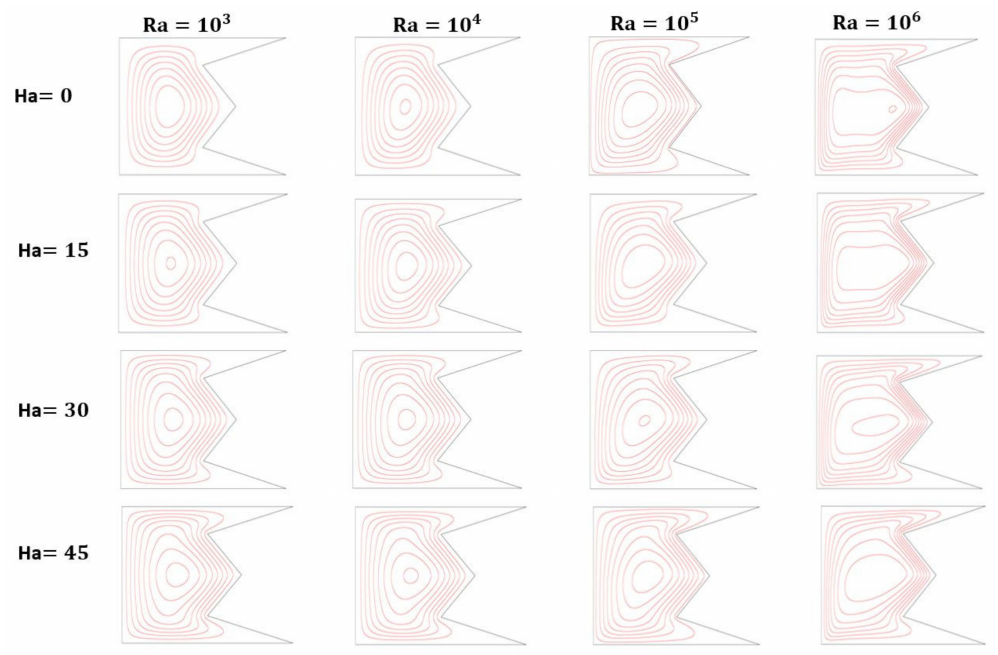
Figure 6. Streamlines for di ff erent values of Rayleigh numbers (Ra = 10 3 , 10 4 , 10 5 and 10 6 ) and Hartmann numbers (Ha = 0, 15, 30 and 45), Da = 10 − 2 , AR = 0.3, ω = 0, ϕ = 0.04, Fr = 0.75 and q ∗ =